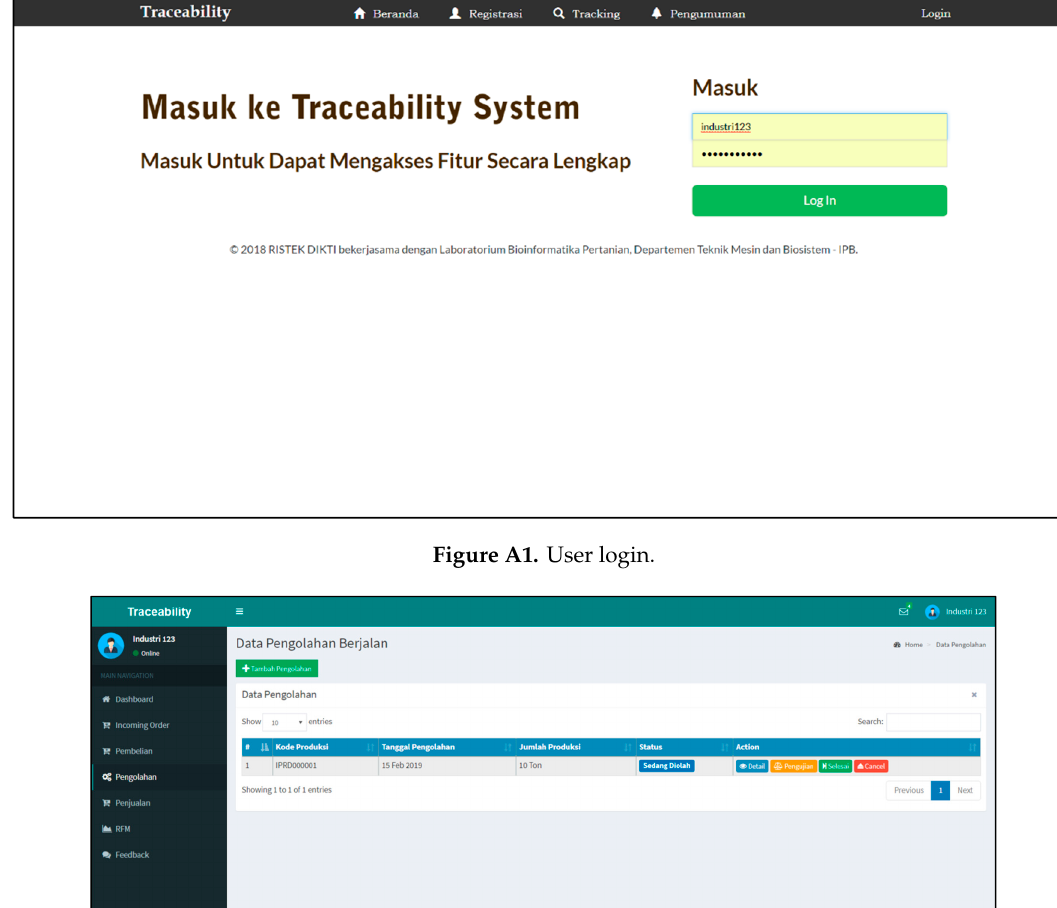
Figure A2. Documentation interface on rice processing.